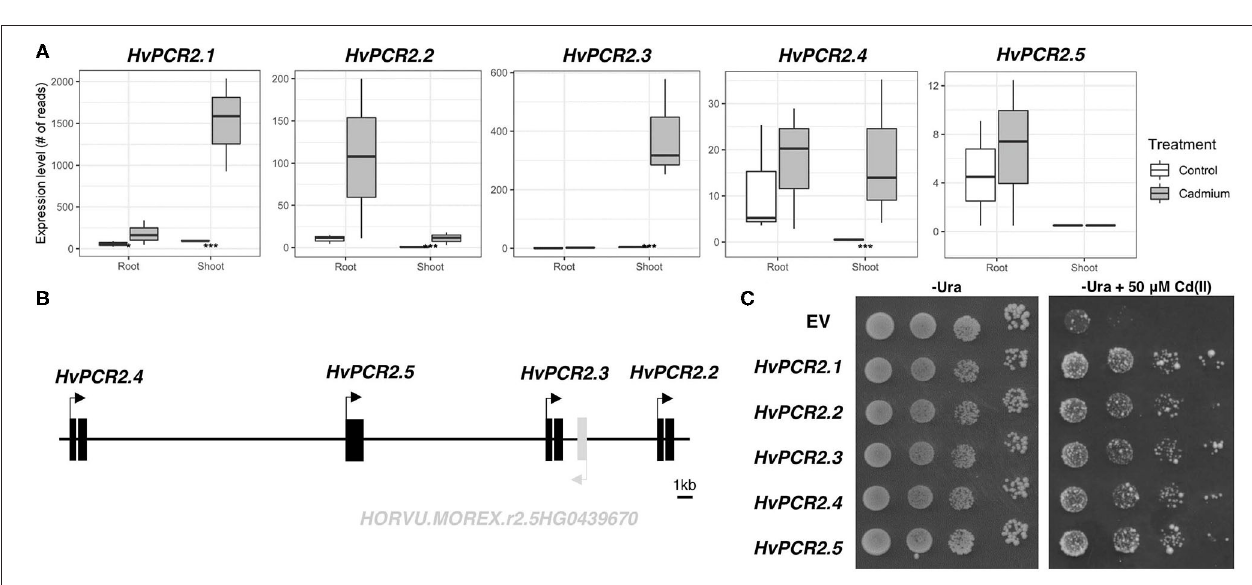
FIGURE 6 | Expression, gene cluster structure, and functional analyses of HvPCR2 . Transcription profiles of all HvPCR2 genes in control and after Cd exposure in root and shoot tissue (A) . Box plot showing the expression level of a gene as count of reads for both root and shoot tissues in control and cadmium treated conditions. The difference between control and treatment was statistically tested and the adjusted P -value < 0.05 is displayed as an asterisk (*), similarly P -value < 0.005 is displayed as (***). Schematic diagram of the ∼ 35kb long genomic region of barley chromosome 5H containing HvPCR2.2-5 genes in tandem array (B) . Expression of HvPCR2 genes restore the Cd tolerance in yeast mutant DTY168 ( 1 ycf1 ) (C) . Growth of DTY168 yeast cultures transformed with empty vector (EV) or constructs containing HvPCR2 genes on solid media with and without addition of